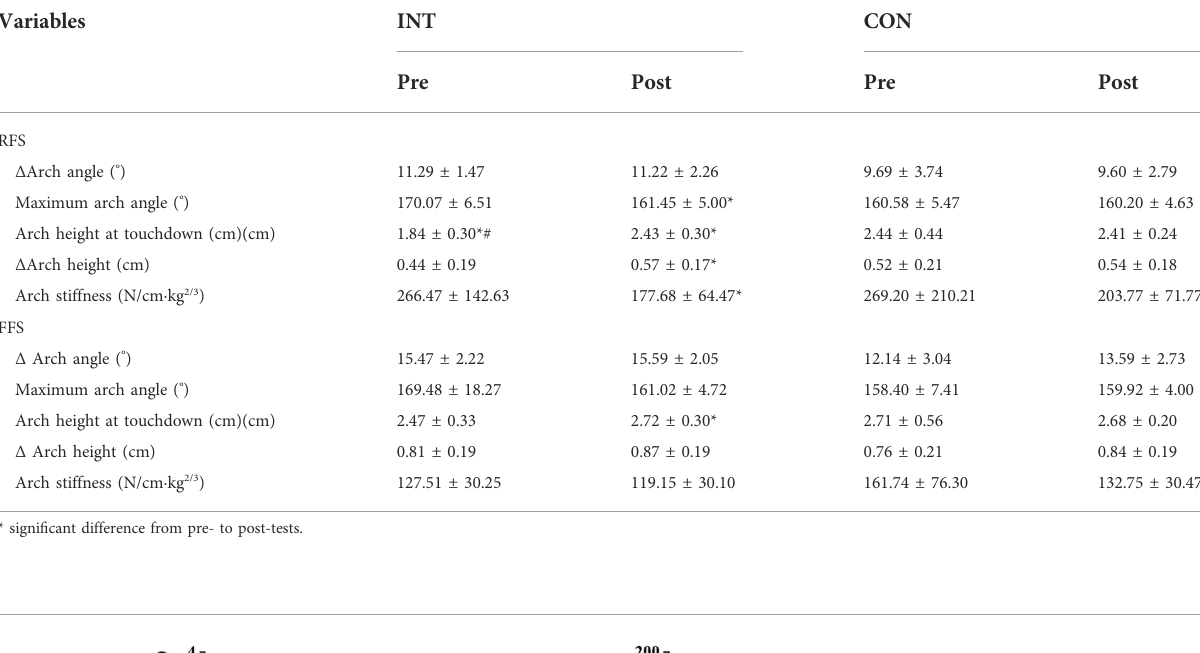
Frontiers in Bioengineering and